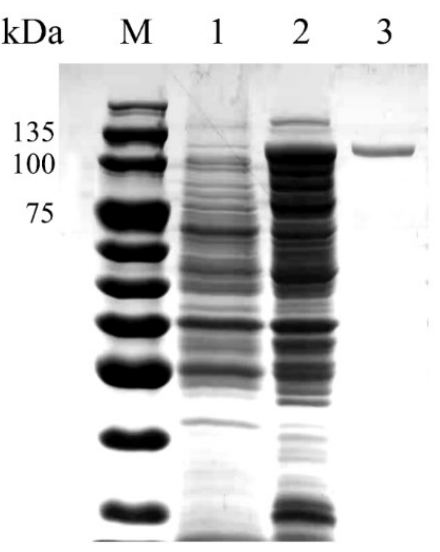
Figure 2. SDS-PAGE analysis of the purified OUC-FaFcn1. Lane M, protein molecular mass marker. Lane 1, the extract of E. coli BL21 (DE3) with pET-28a (+) vector (control). Lane 2, the crude enzyme extract. Lane 3, OUC-FaFcn1 purified by Ni-affinity chromatography. Table 1. Summary of the purification procedures of the recombinant OUC-FaFcn1 that was harvested from 1 L culture broth.